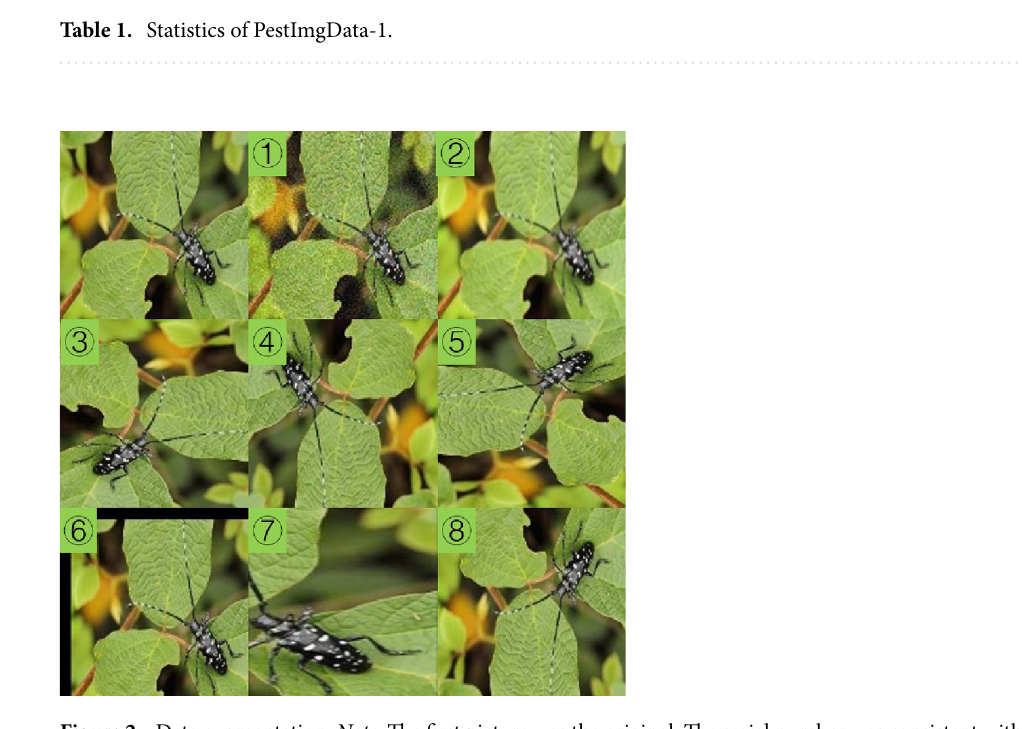
Figure 2. Data augmentation. Note : The first picture was the original. The serial number was consistent with the description in the above